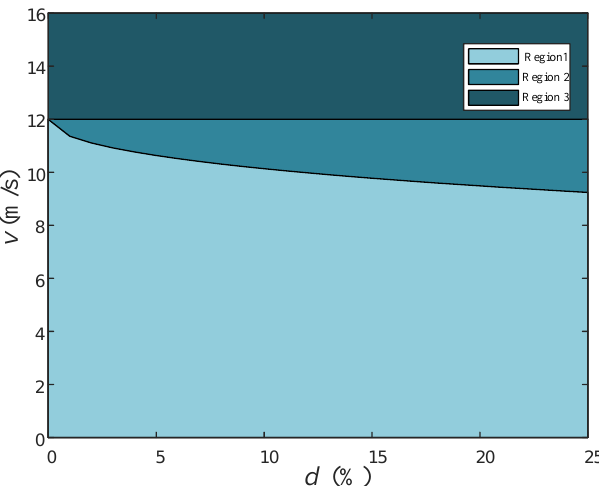
Figure 3. Division of wind power primary FR cooperative control area.